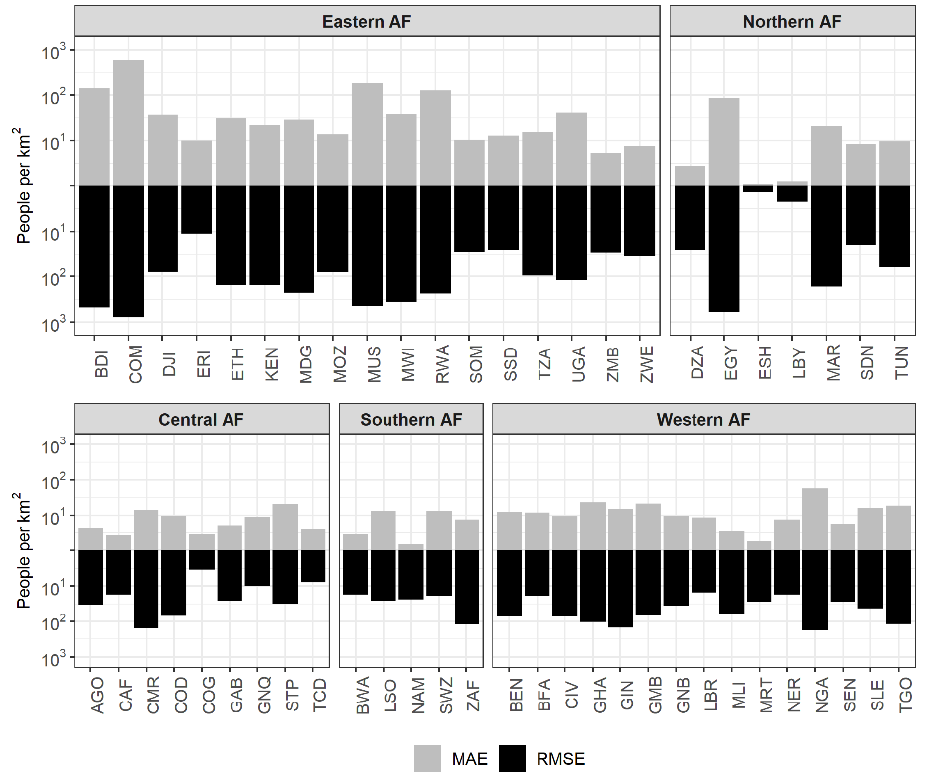
Figure 5. Bar plots of the distribution of the mean absolute error (MAE) (grey) and Root Mean Square Error (RMSE) (black) of the population density for each country (ISO) within each region. Table 3. Statistical metrics for population density.